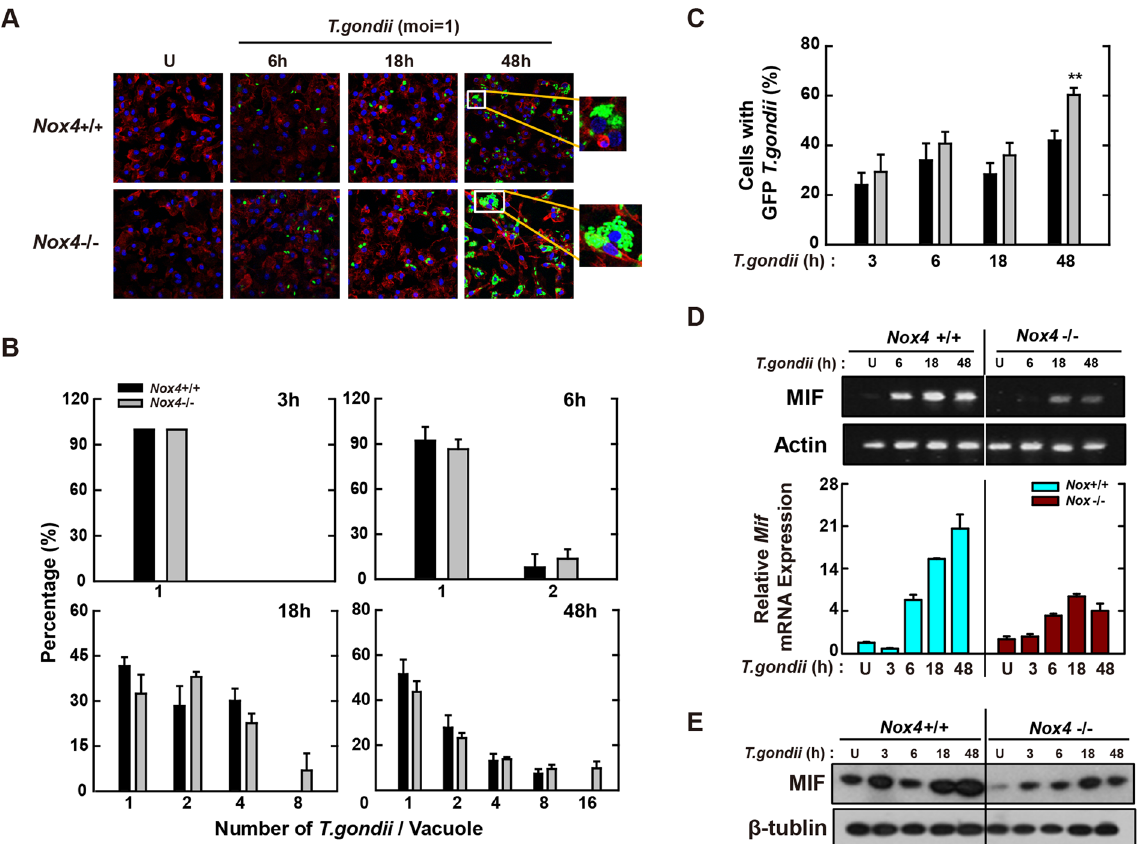
Figure 6. Nox4 is essential for the activation of protective immunity in T . gondii -infected macrophages. ( A – C ) BMDMs from Nox4 + / + and Nox4 − / − mice were infected with GFP-RH strain (moi = 1) for the indicated time periods. ( A ) Cells were fixed and stained with Texas Red ® -X phalloidin for labeling F-actin (red) for cytosolic fraction, and DAPI (blue) for nuclei and then analyzed for the number of GFP-RH strain using confocal microscopy ( B , C ) The number of GFP-RH strain per vacuole (for B) or of GFP-RH strain-infected cell (for C) were analyzed. Scale bar = 25 μ m. Data are representative of five independent experiments ( D , E ) BMDMs from Nox4 + / + and Nox4 − / − mice were infected with T . gondii RH strain (moi = 1) for the indicated time periods. ( D ) The mRNA expression for Mif and actb was determined using semiquantitative RT-PCR (top) or qPCR (bottom) analysis. ( E ) Immunoblot analysis was performed to determine protein expression of MIF and β -tubulin. Data are representative of three independent experiments and are presented as means ± SD. * P < 0.05, ** P < 0.01, *** P < 0.001, two-tailed Student’s